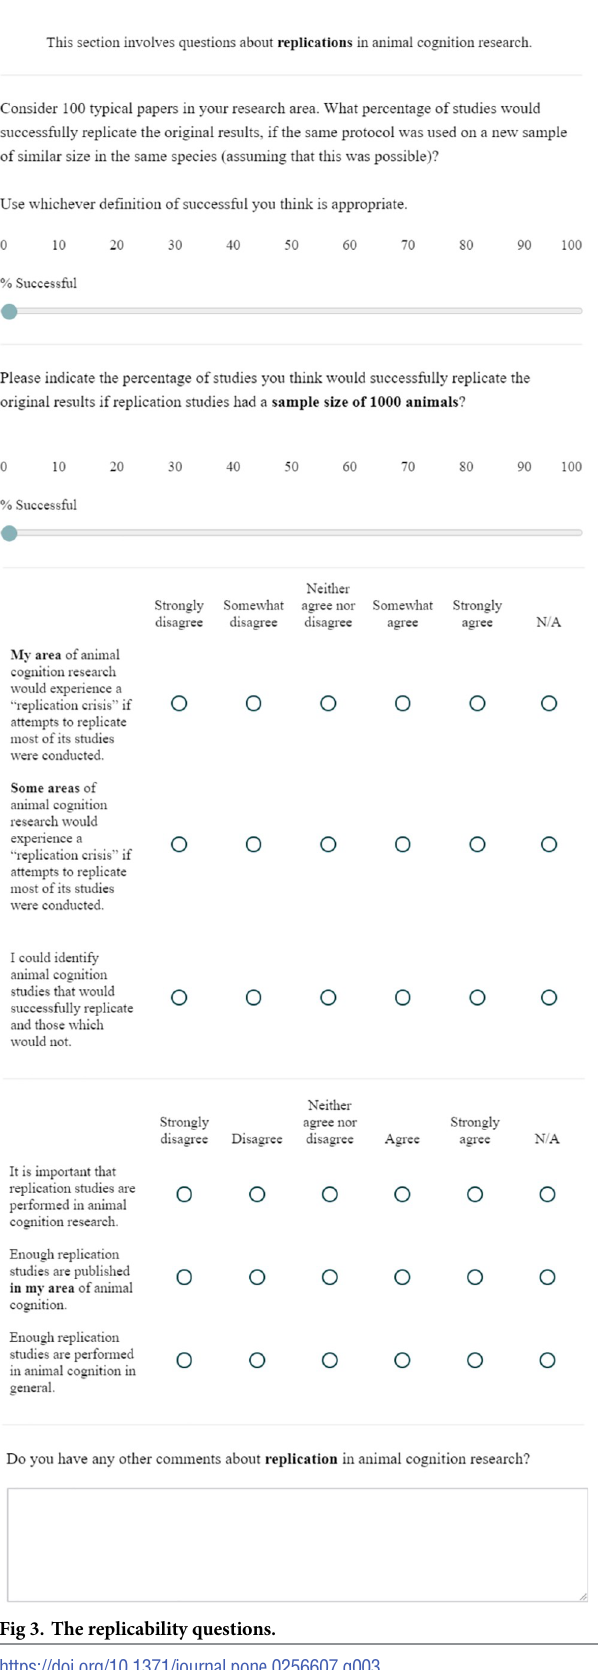
Fig 3. The replicability